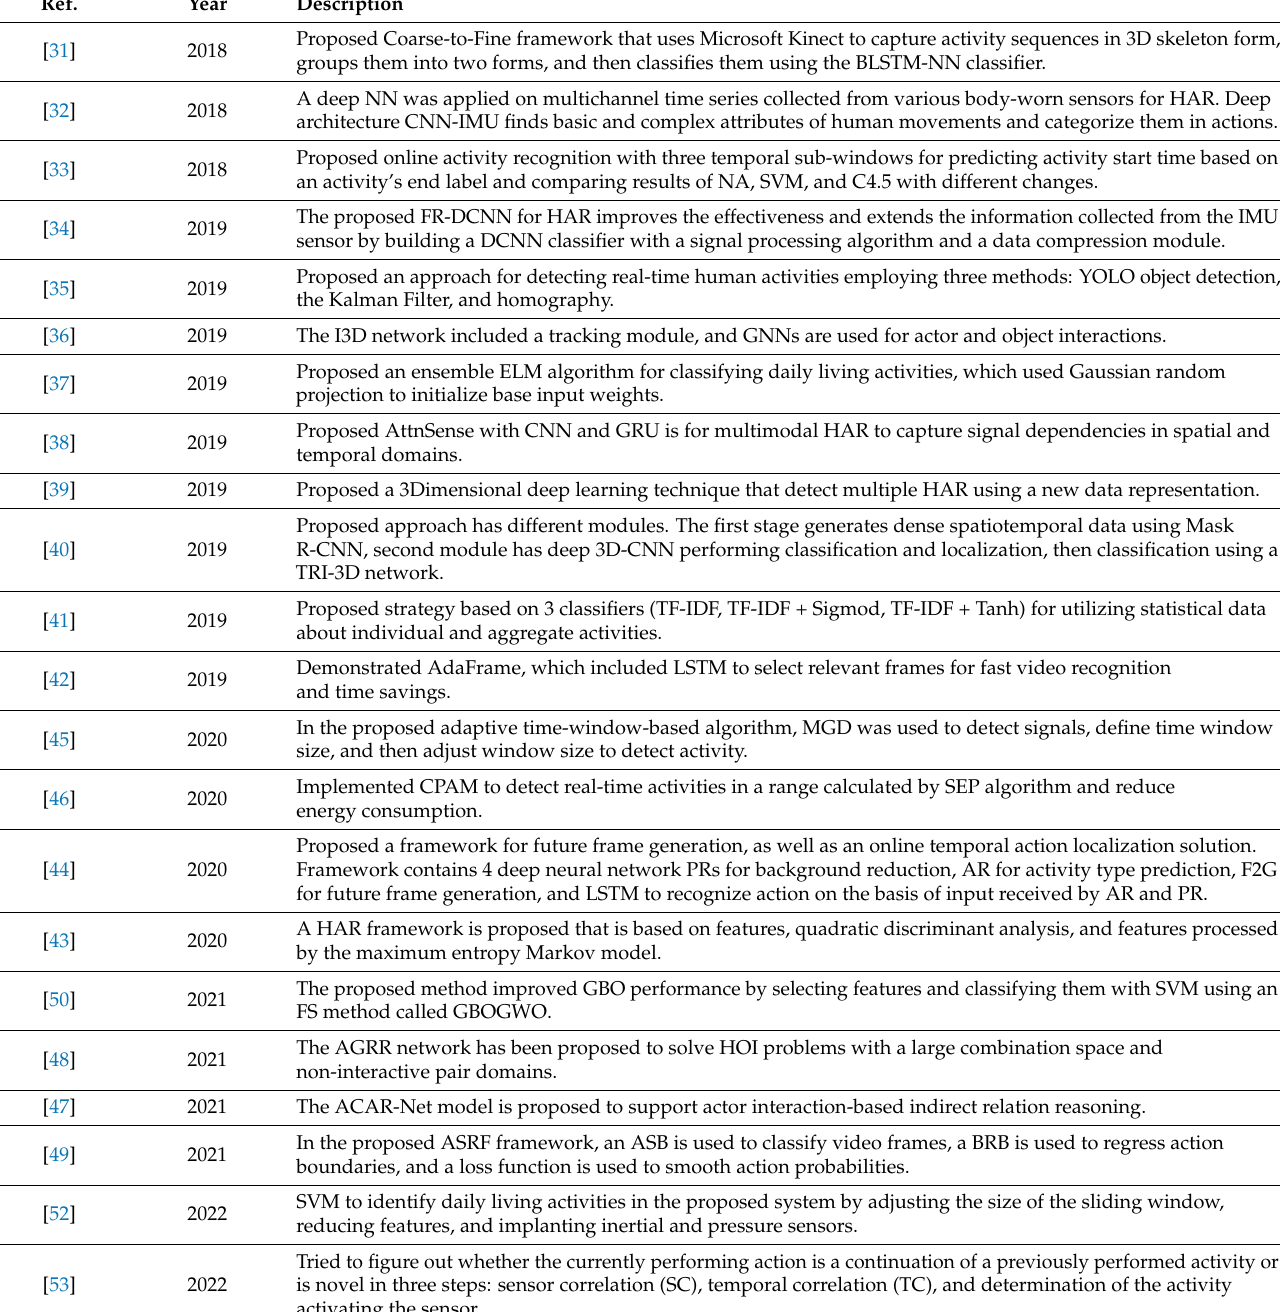
Table 2. Summary of literature on dynamic